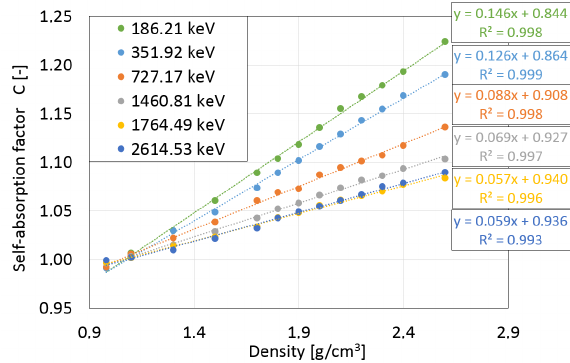
Figure 7. Correction factor for M600 geometry filled with brick.